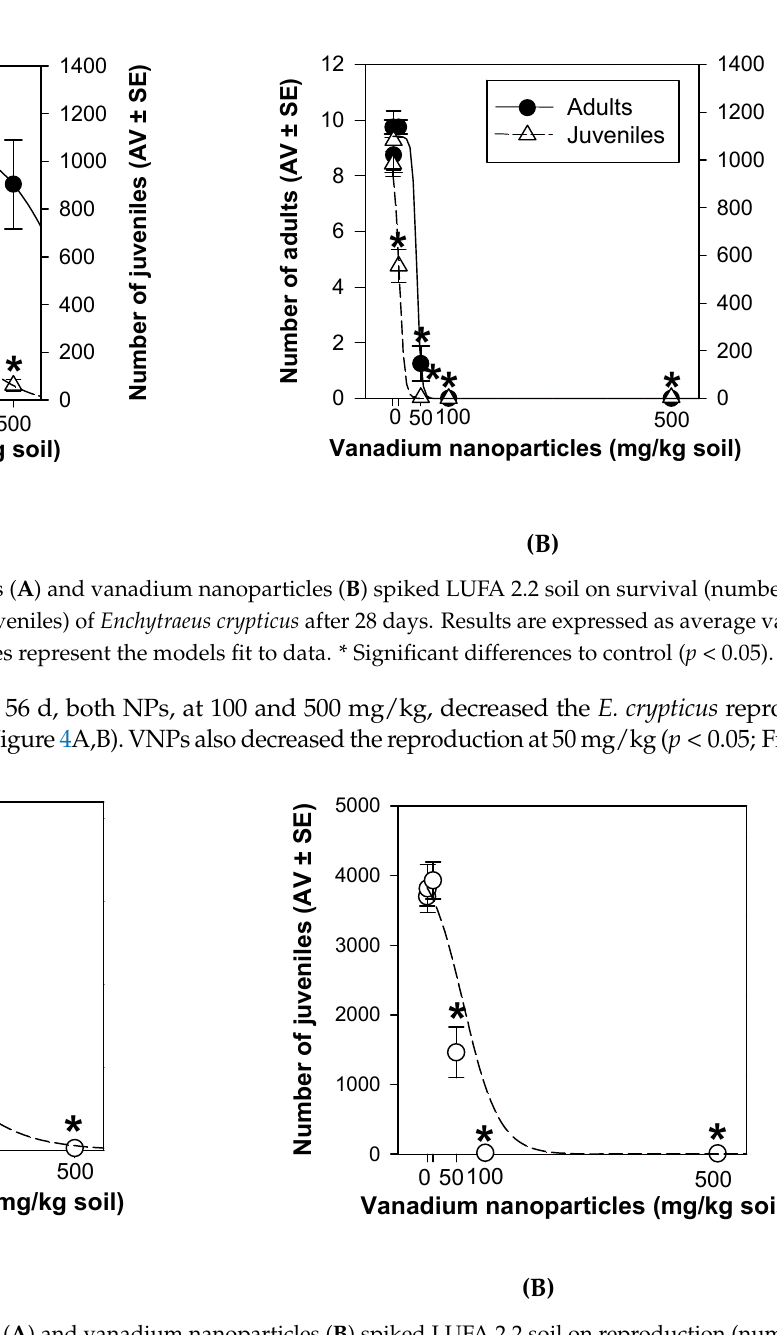
Figure 4. Effects of boron nanoparticles ( A ) and vanadium nanoparticles ( B ) spiked LUFA 2.2 soil on reproduction (number of juveniles) of Enchytraeus crypticus after 56 days. Results are expressed as average value (AV) ± standard error (SE) (n = 4). Lines represent the models fit to the data. * Significant differences to control ( p < 0.05). For survival, it was not possible to calculate a EC x for BNPs due to the lack of effect detected in this endpoint (Table 2). In addition, for VNPs, no suitable model fit to the data from survival (Table 2). For reproduction, the calculated EC x values were higher for BNPs than VNPs at both exposure times (28 and 56 d) (Table 2).